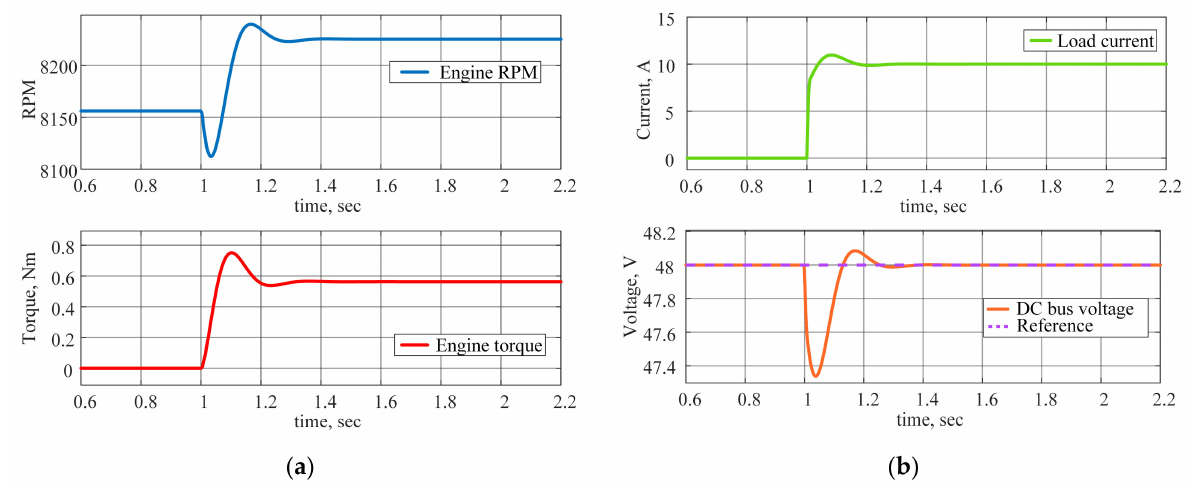
Figure 13. Simulation results of ICE-EG set DC bus voltage control system with PID controller: ( a ) ICE quantities; ( b ) EG